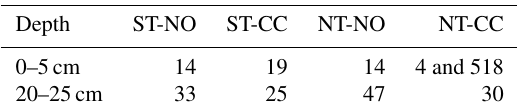
Table 2. Modal diameter (µm) of the pore size distribution curves. Depth ST-NO ST-CC NT-NO NT-CC